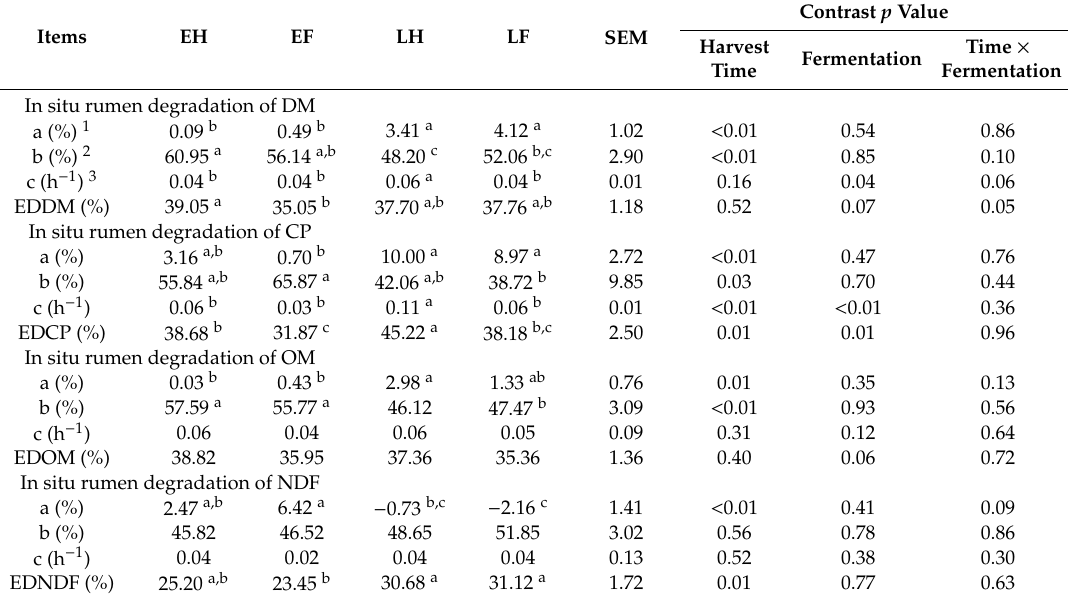
Table 5. E ff ects of harvest time and microbial anaerobic fermentation treatment on In situ rumen degradation of whole Zhang hybrid